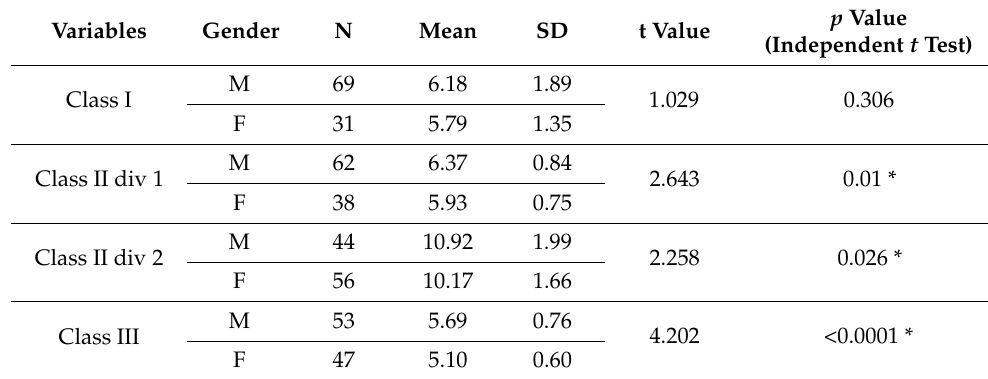
Table 2. Gender-wise comparison of